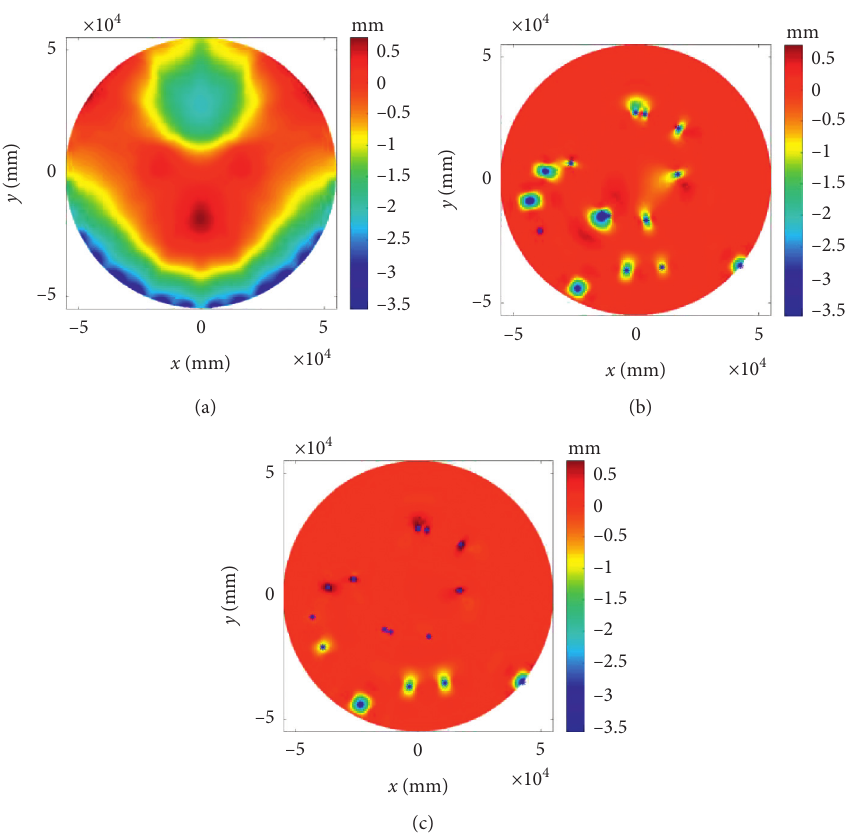
Figure 10: Compare with the main reflector deformation at 35deg elevation. (a) The reflector deformation before actuator failure. (b) The reflector deformation after actuator failure. (c) The reflector deformation at tolerance method.